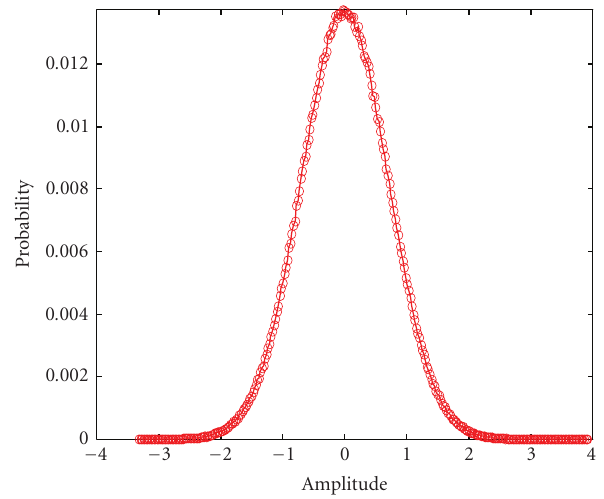
Figure 1: Inphase/quadrature component histogram of a 256 subcarrier OFDM signal.